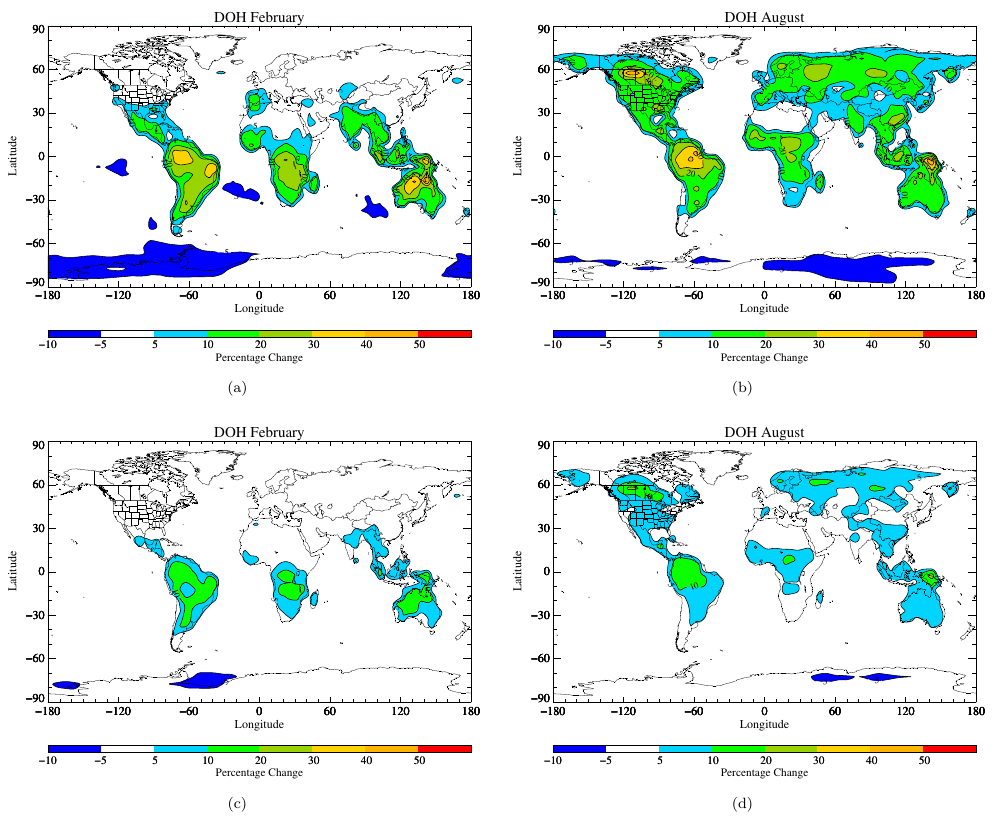
Figure 10. Percentage difference plots for the global model sensitivity runs, relative to the base case for OH. %=((Run-Base)/Base) · 100: (a) February, Mechanism 4R; (b) August, Mechanism 4R; (c) February, Mechanism 4Ra; (d) August, Mechanism 4Ra.